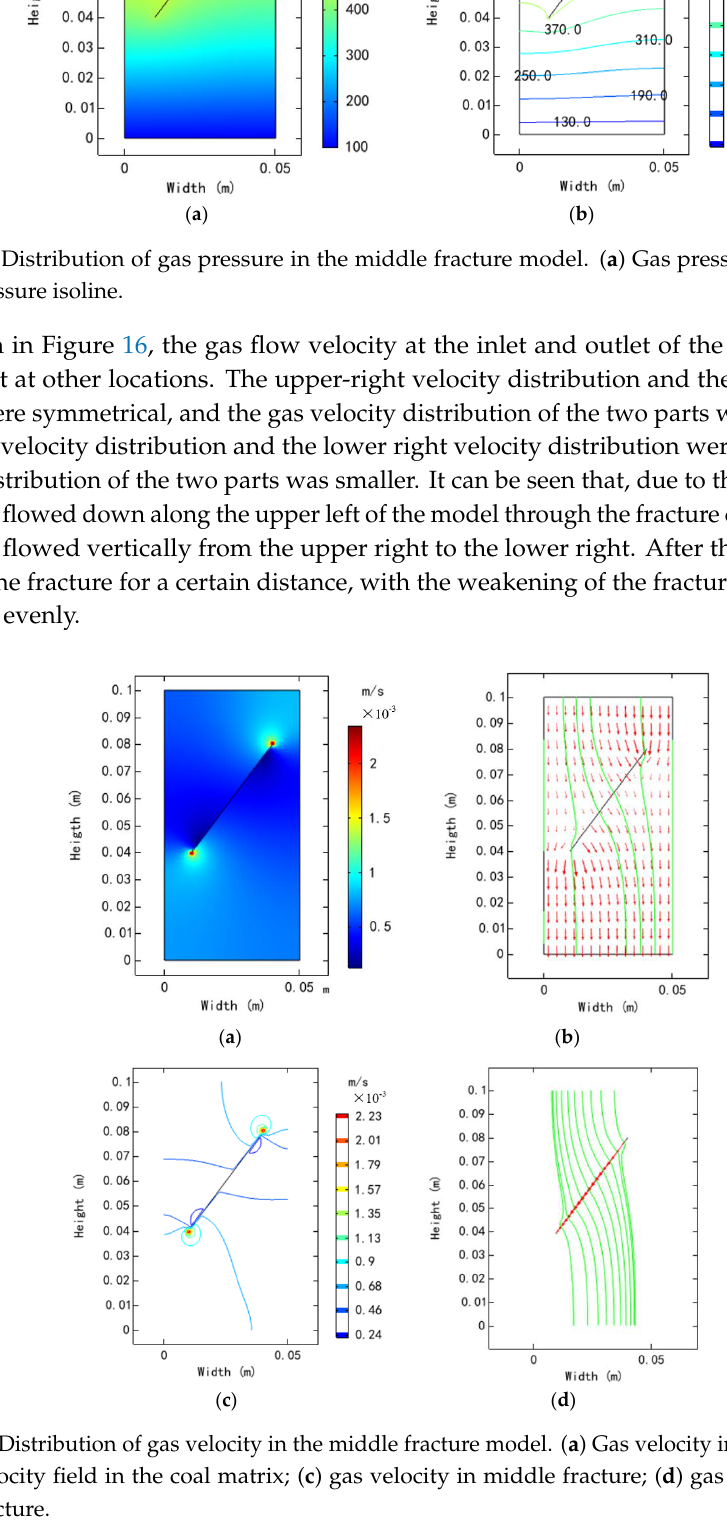
( b ) Figure 17. Distribution of gas pressure in the lower fracture model. ( a ) Gas pressure nephogram; ( b ) gas pressure isoline. As shown in Figure 18, the gas flow in the upper half of the model was relatively uniform as a whole, and the flow velocity at the fracture inlet was relatively high. The flow velocity in the upper half of the model was higher than that in the lower half. Part of the gas entered the fracture channel from the fracture inlet, and part of the gas entered the fracture channel from the matrix perpendicular to the fracture surface. The velocity field was uniform in the upper half, pointing vertically downward. The velocity field began to skew towards the entrance at a position of about 0.02 m above the fracture entrance. Due to the existence of the lower fracture, most of the gas flowed out of the model along the fracture channel, and only a small part flowed out from the right lower side of the model.